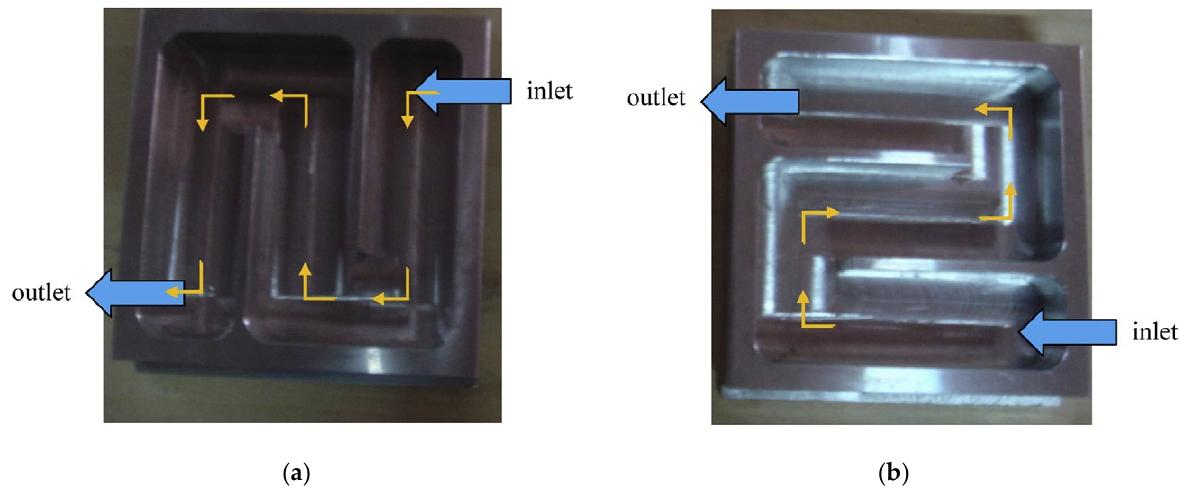
Figure 5. Meander cooling unit with inflow and outflow: ( a ) Perpendicular to the channel; ( b ) Parallel to the channel. Reprint with permission [55]; Copyright 2021, Elsevier.